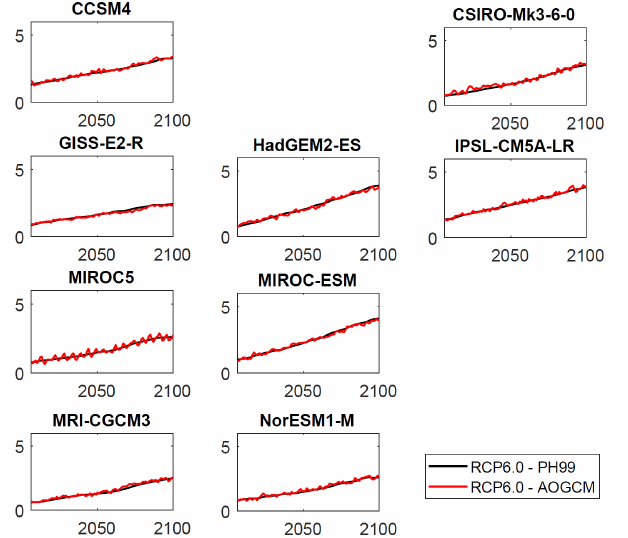
Figure B1. The comparison of temperature evolutions projected by the climate module PH99 (black solid curves) in the RCP6.0 scenario to the actual AOGCM’s temperature (red solid curves) in the RCP6.0 scenario. α and µ are taken from the second step, in which PH99 is calibrated to the RCP2.6